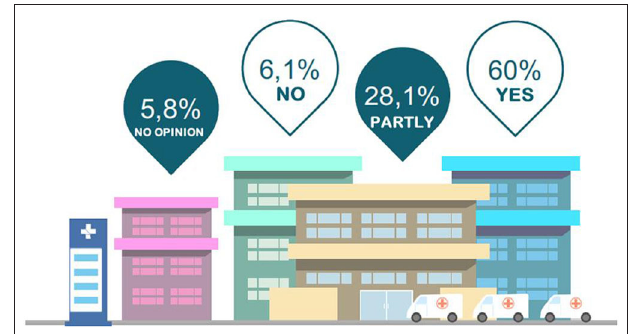
FIGURE 13 | AVASUS learning application.